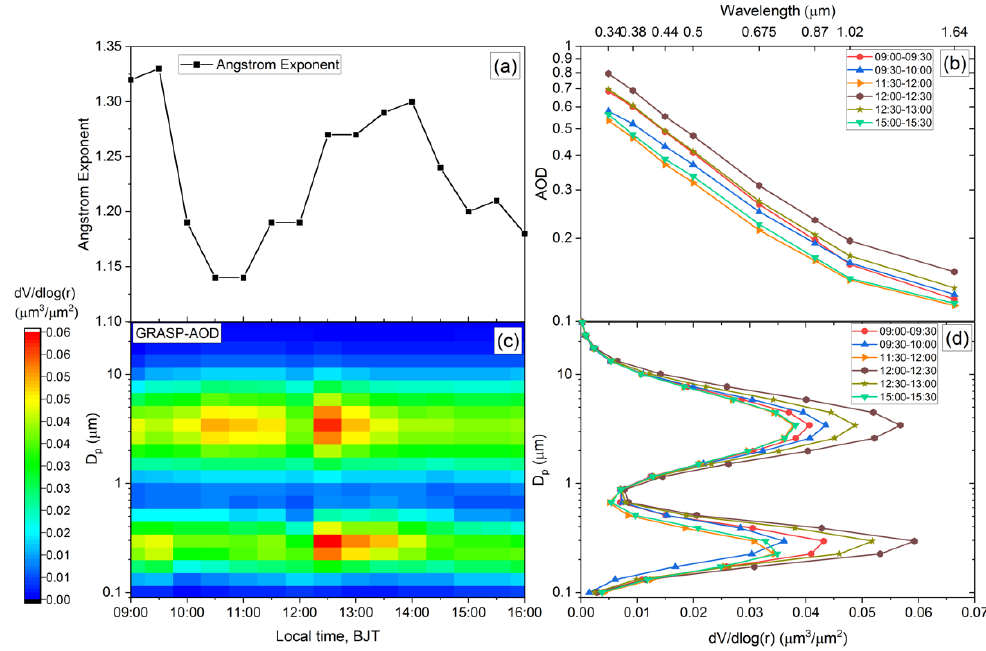
Figure 7. Spatio-temporal variability of ( a ) Angstrom Exponent (AE), ( b ) spectral AOD, ( c ) total column VSD retrieved with GRASP-AOD for every transect segment and ( d ) columnar VSD for some time intervals along the mobile transect. All size distributions were averaged on 30 min time intervals and can be localized on the mobile transect using the map color-coded by local time in Figure 4a.